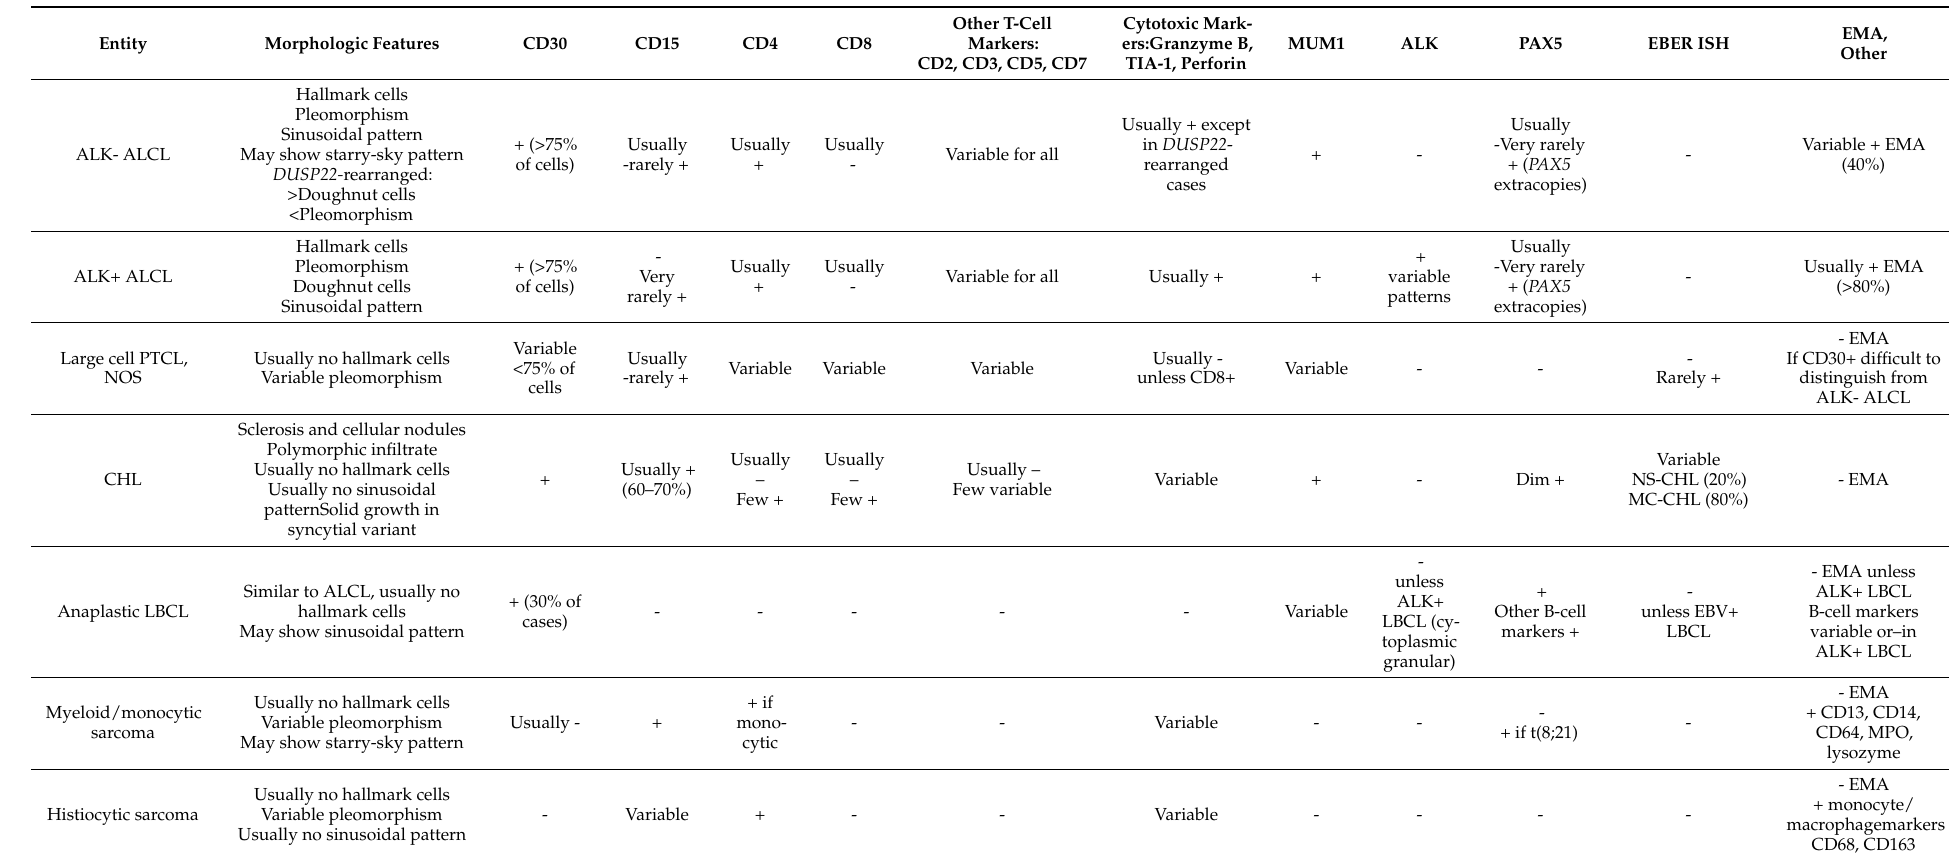
Table 1. Differential diagnosis of ALK- ALCL and other hematopoietic